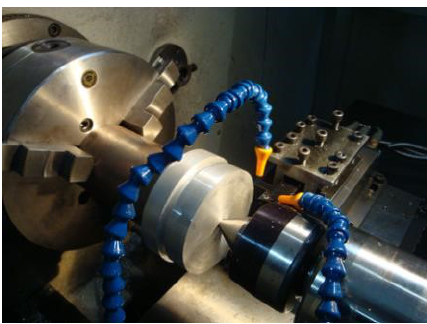
Figure 4. Force gauge and oil mist feeding nozzles.